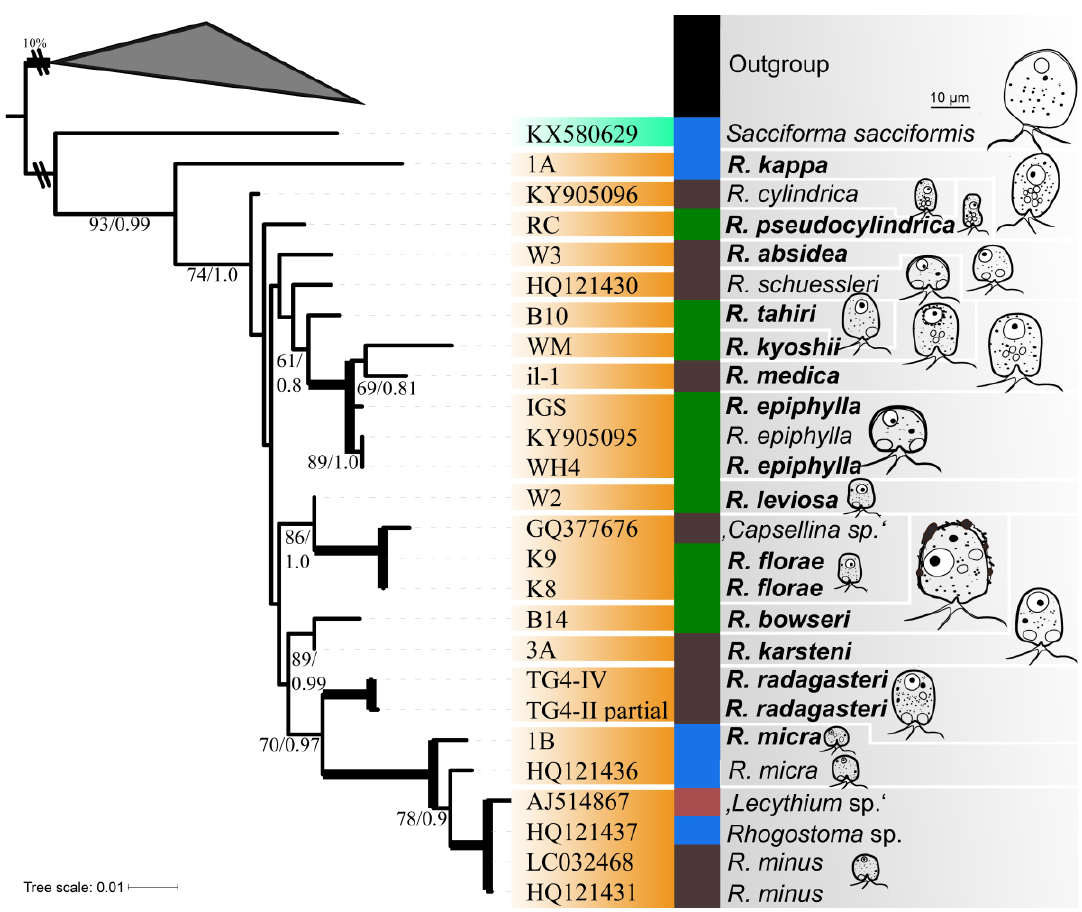
Figure 3. SSU rDNA phylogeny of sequenced and described Rhogostomidae (highlighted in orange for Rhogostoma spp. and cyan for Sacciforma ) with chosen Tectofilosida as outgroup. Shown is the maximum likelihood tree obtained by the RAxML GTR + I + G analyses including 34 sequences. Species names of in this study sequenced strains are highlighted in bold. Support values are given in bootstraps and posterior probabilities (BT / PP) if BT was ≥ 50%; bold branches indicate bootstrap support of 100%. Isolation habitats are highlighted: blue indicates freshwater origin, brown indicates soil origin, green indicates strains from the phyllosphere and red indicates wastewater treatment plant origin. Drawings of Rhogostomidae, highlighting their morphological traits, are given to scale, enabling a quick visual comparison of each species. Scale bar indicates 10 μm.